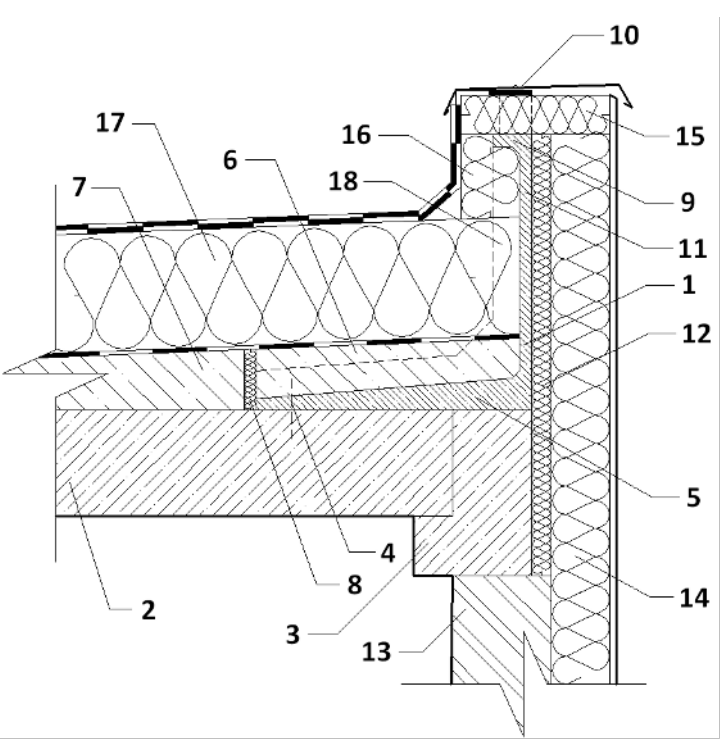
Figure 3. Example of parapet block installation on the ceiling structure of precast concrete frame construction system. Notes : 1 - parapet block, 2 - reinforced concrete ceiling panel, 3 - reinforced concrete beam, 4 - anchoring of parapet block, 5 - horizontal part of parapet block, 6 - monolithic concrete - layer forming a gradient and stabilizes the parapet block, 7 - monolithic concrete - layer forming a gradient, 8 - dilatation, elastic strip, 9 - the upper part of the parapet block, 10 - anchoring of parapet block, 11 - vertical part of parapet block, 12 - lower thermal insulation layer (compensation for reinforced concrete elements), 13 - filling masonry of perimeter wall, 14 - main thermal insulation layer (ETICS), 15 - insulation of parapet extruded polystyrene (XPS), 16 - insulation of parapet block, 17 - conventional roofing layers of flat roof, 18 - reinforcing rib of parapet